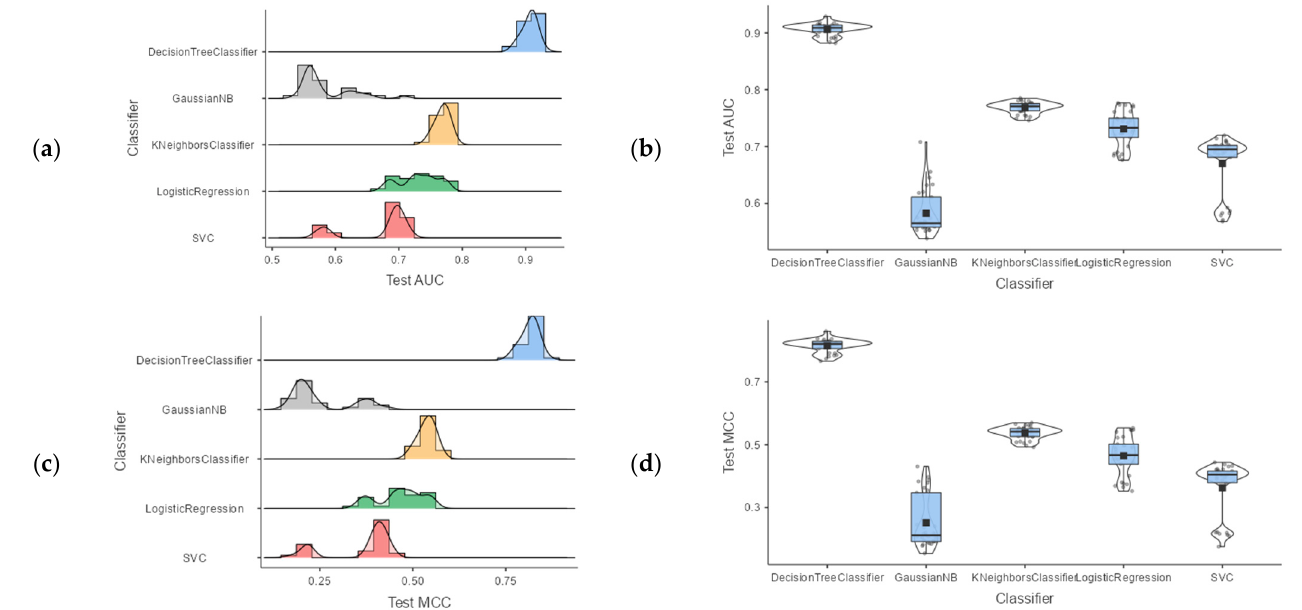
Figure 4. The AUC and MCC results of the five tested classifiers depicted through histograms ( a , c ) and violin plots ( b , d ).